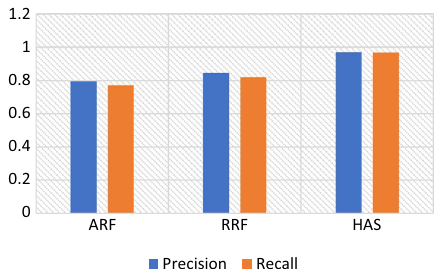
Fig. 3 Precision and recall assessment of the proposed feature extraction methodologies using LSTM